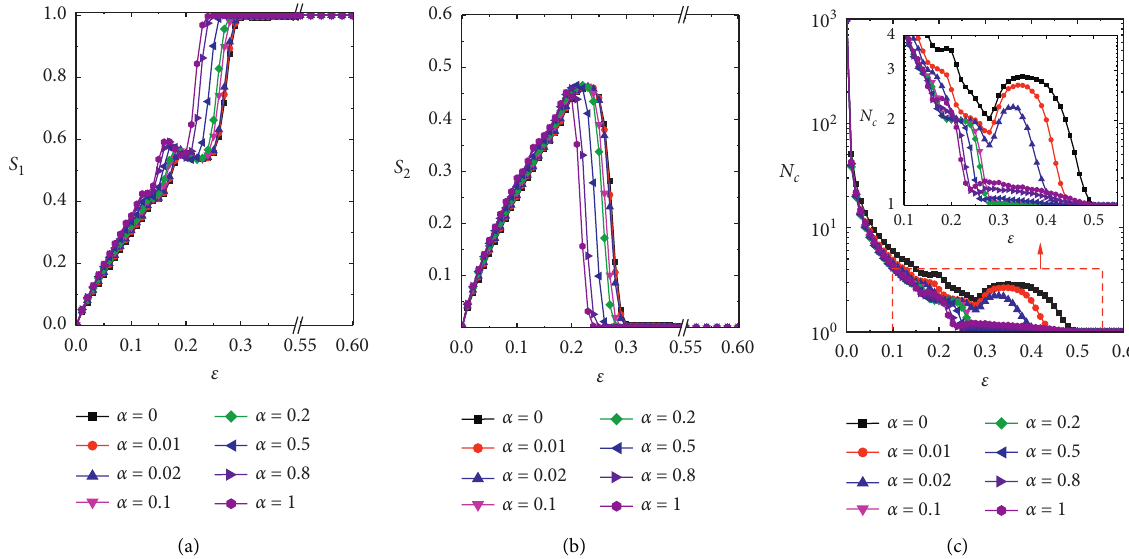
Figure 4: (a) The relative size of the largest opinion cluster S as a function of ε at different α . (b) The relative size of the second largest 1 as a function of ε at different α . (c) The number of clusters N c as a function of ε at different α . An enlargement of the region opinion cluster S 2 for small N c is shown in the inset. α � 0 , 0 . 01 , 0 . 02 , 0 . 1 , 0 . 2 , 0 . 5 , 0 . 8, and